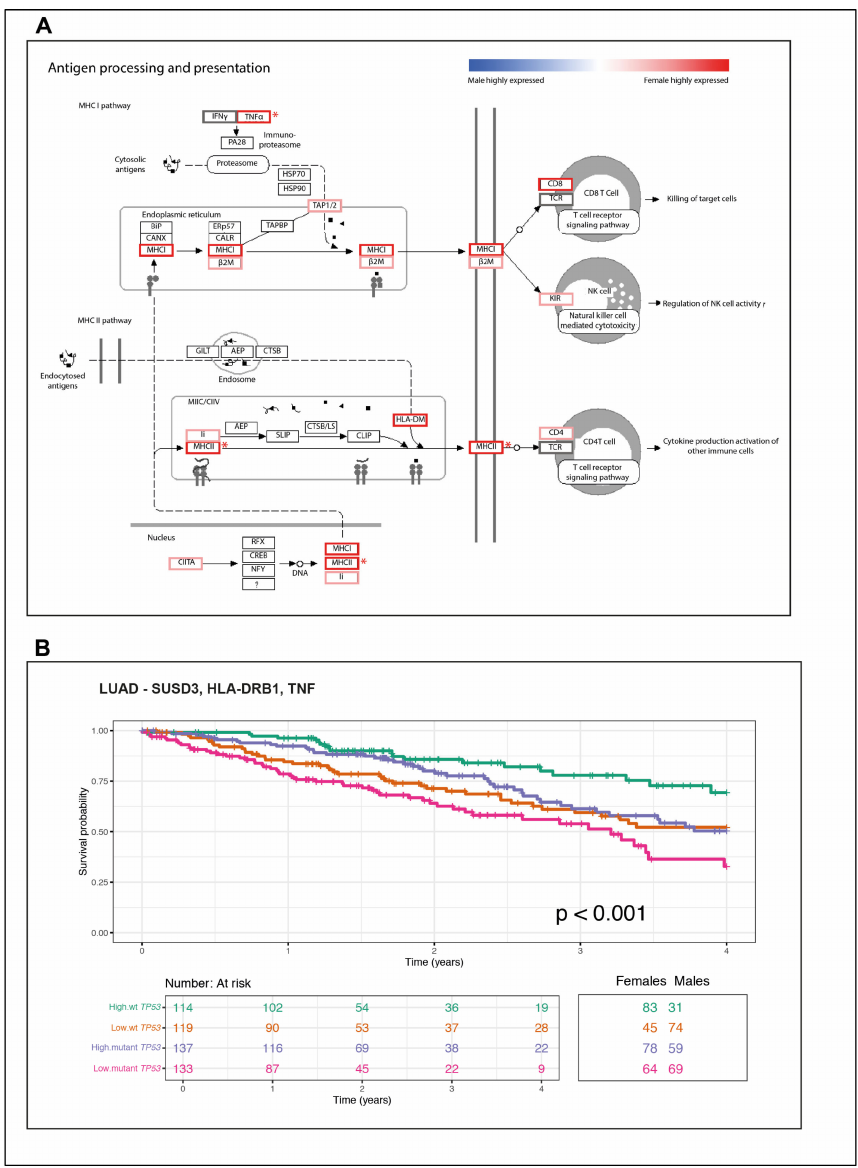
Figure 4. The wt TP53 LUAD females are enriched in antigen processing and presentation pathways with links to longevity. Numerous immune signature genes that were identified to be most highly di ff erentially expressed in wt TP53 LUAD in females, compared to their counterpart males, occur in the Kyoto Encyclopedia of Genes and Genomes (KEGG) antigen processing and presentation pathways as depicted ( A ). Note in this pathway diagram, Major Histocompatibility Complex Class II DR Beta 1 (HLA-DRB1) is referred to as Major Histocompatibility Complex, Class II (MHCII). Pathway genes with a positive log fold change (logFC) in females are outlined in red, while those with a negative logFC would be shaded blue (i.e., those more highly expressed in males). Grey outline indicates a logFC close to zero (i.e., similar expression levels between females and males). Genes with significant di ff erential expression ( p- value < 0.05) are indicated with a red asterisk. ( B ) Survival analyses for LUAD patients stratified by TP5 3 mutation status (wt or mutant) and the relative expression levels of the three gene signature: Sushi Domain Containing 3 (SUSD3), Major Histocompatibility Complex Class II DR Beta 1 (HLA-DRB1), and Tumour Necrosis Factor (TNF). The numbers of males and females corresponding to each cohort, stratified for high or low expression of the respective genes, in either a wt or mutant TP53 context are tabulated below each plot. The ‘ p ’ is the p -value for the log-rank test of di ff erences in survival time (significant p -value <